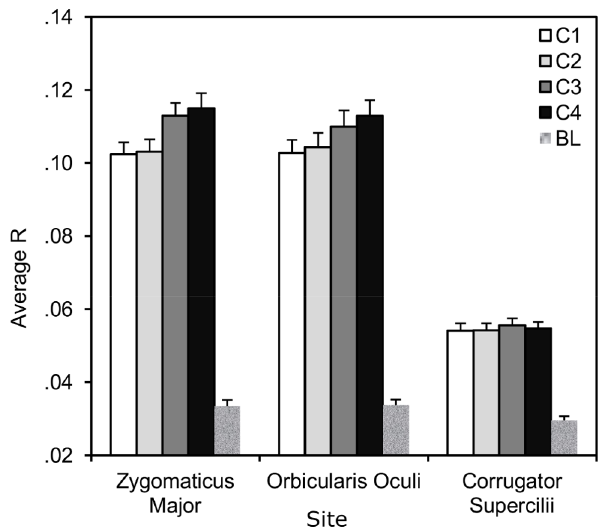
Figure 4. EMG linkage. Mean squared cross-correlation in EMG collected from three facial muscle groups as a function of competition (C1: cooperative, C2: competitive against computer, C3: competitive with computer, C4: against one another, BL: baseline).